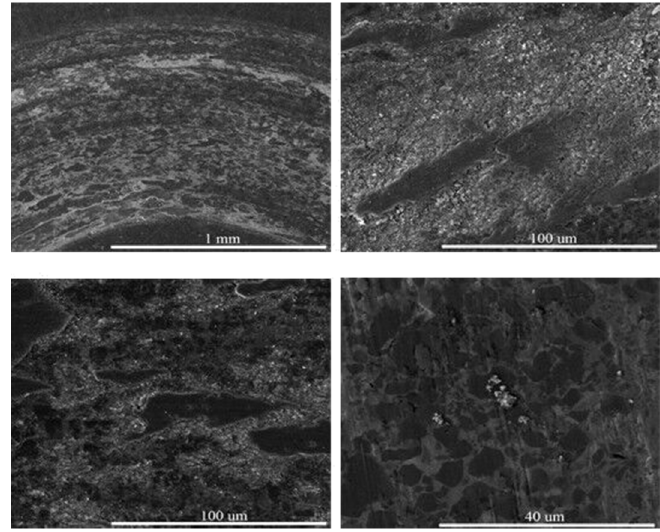
Figure 7. SEM micrographs of the worn surfaces of coating ‐ B .